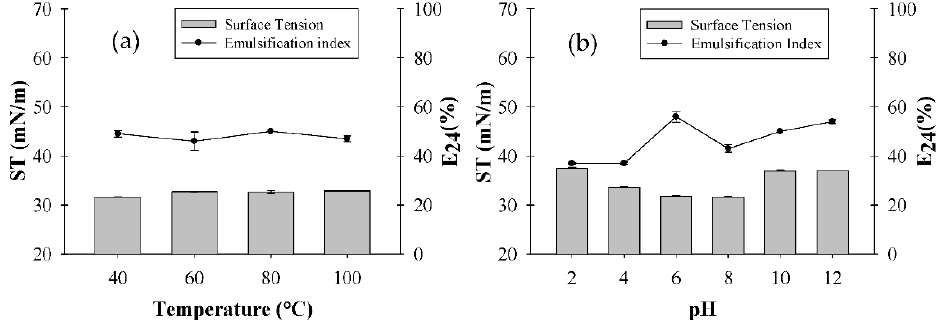
Figure 1. Influence of temperature ( a ) and pH ( b ) on Chenopodium quinoa extract surface tension (ST) and emulsification index (E 24 ).